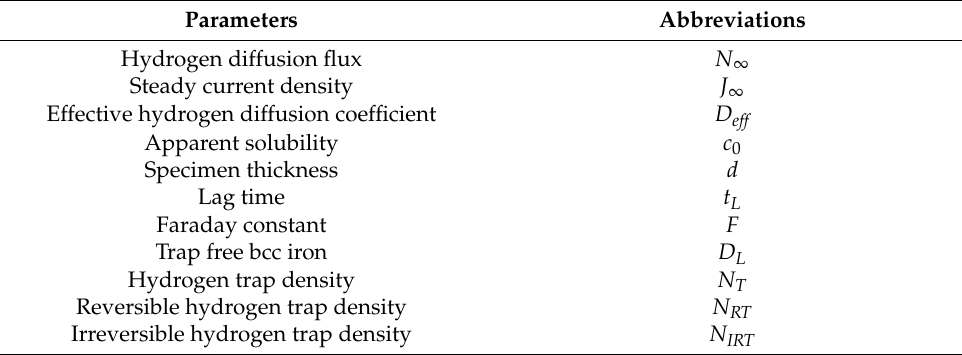
Table A1. Parameters and the corresponding abbreviations in this